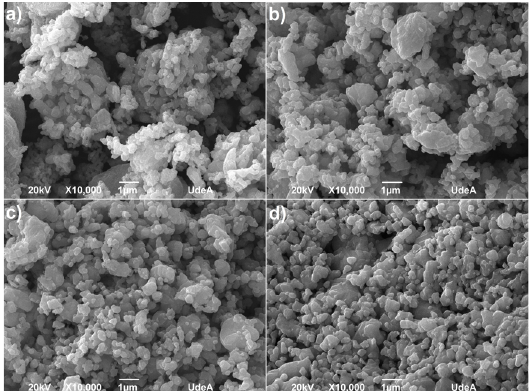
Figure 6. SEM micrographs of (a) the initial mixture of reactants and of the samples submitted to heat treatments at (b) 1000 ºC, (c) 1100 ºC and (d) 1200